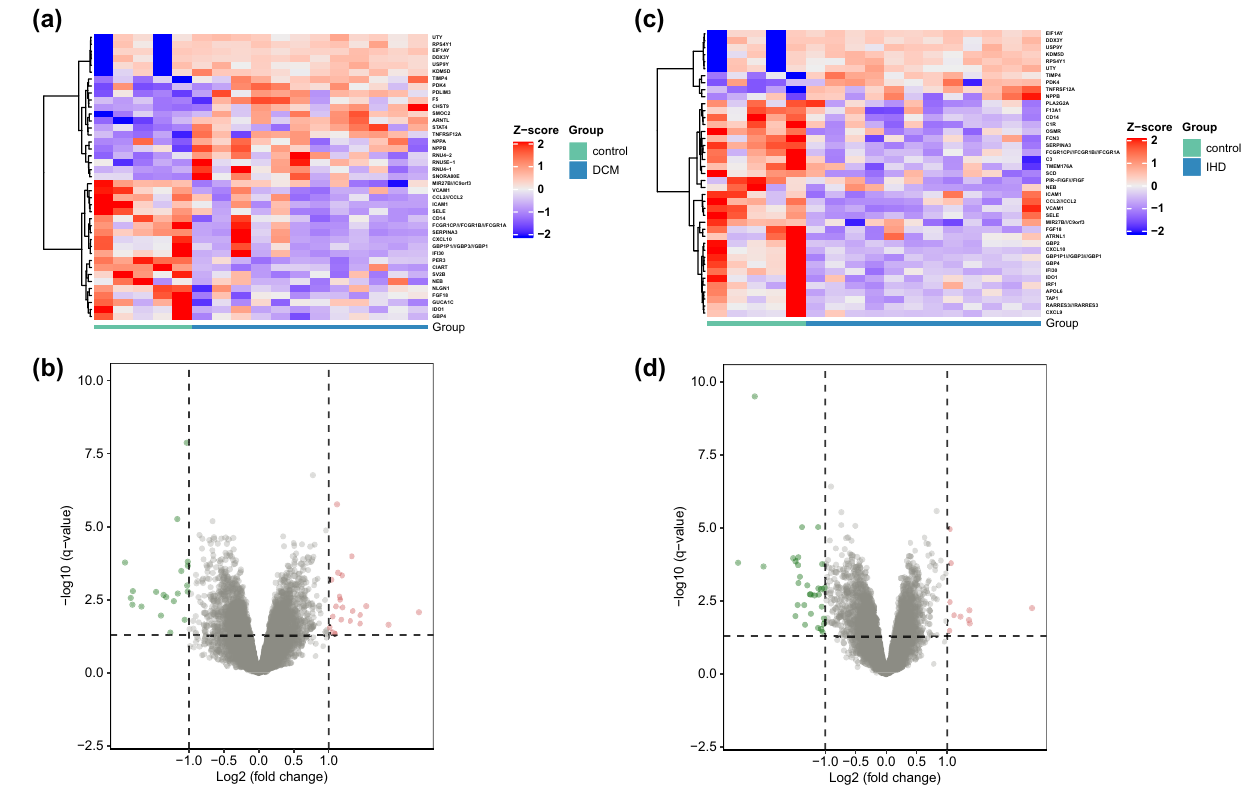
Figure 1. ( a ) Heat map of DEGs screened in myocardial tissue samples of subjects with DCM and controls in the GSE42955 dataset. ( b ) Volcanogram showing DEG screening of myocardial tissue from subjects with DCM and controls in the GSE42955 dataset. ( c ) Heat map of differently expressed genes (DEGs) in myocardial tissue samples of subjects with IHD and controls in the GSE42955 dataset. ( d ) Volcanogram showing DEG screening of myocardial tissue from subjects with IHD and controls in the GSE42955 dataset. ( e ) Intersection of DEGs in the IHD and DCM cohorts. ( f ) Protein–protein interaction (PPI) network for common DEGs. ( g ) The core function modules of the PPI network and the color refers to the